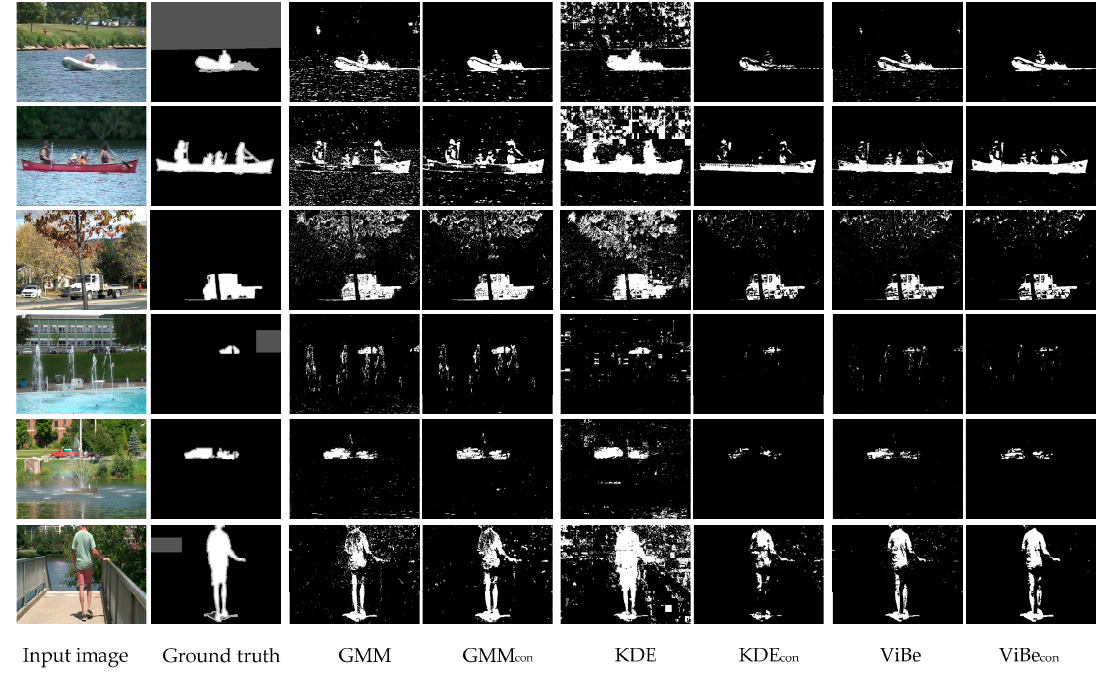
Figure 4. Refinements of the background-subtraction methods on dynamic background.